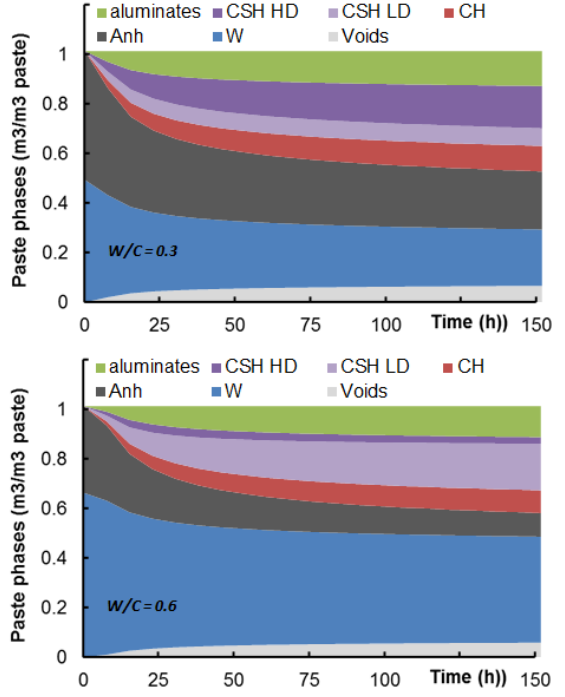
Figure 3. Evolution of paste phases over time for CEM I pastes with W/C = 0.3 and 0.6 (results obtained with the multiphasic hydration model [1]).